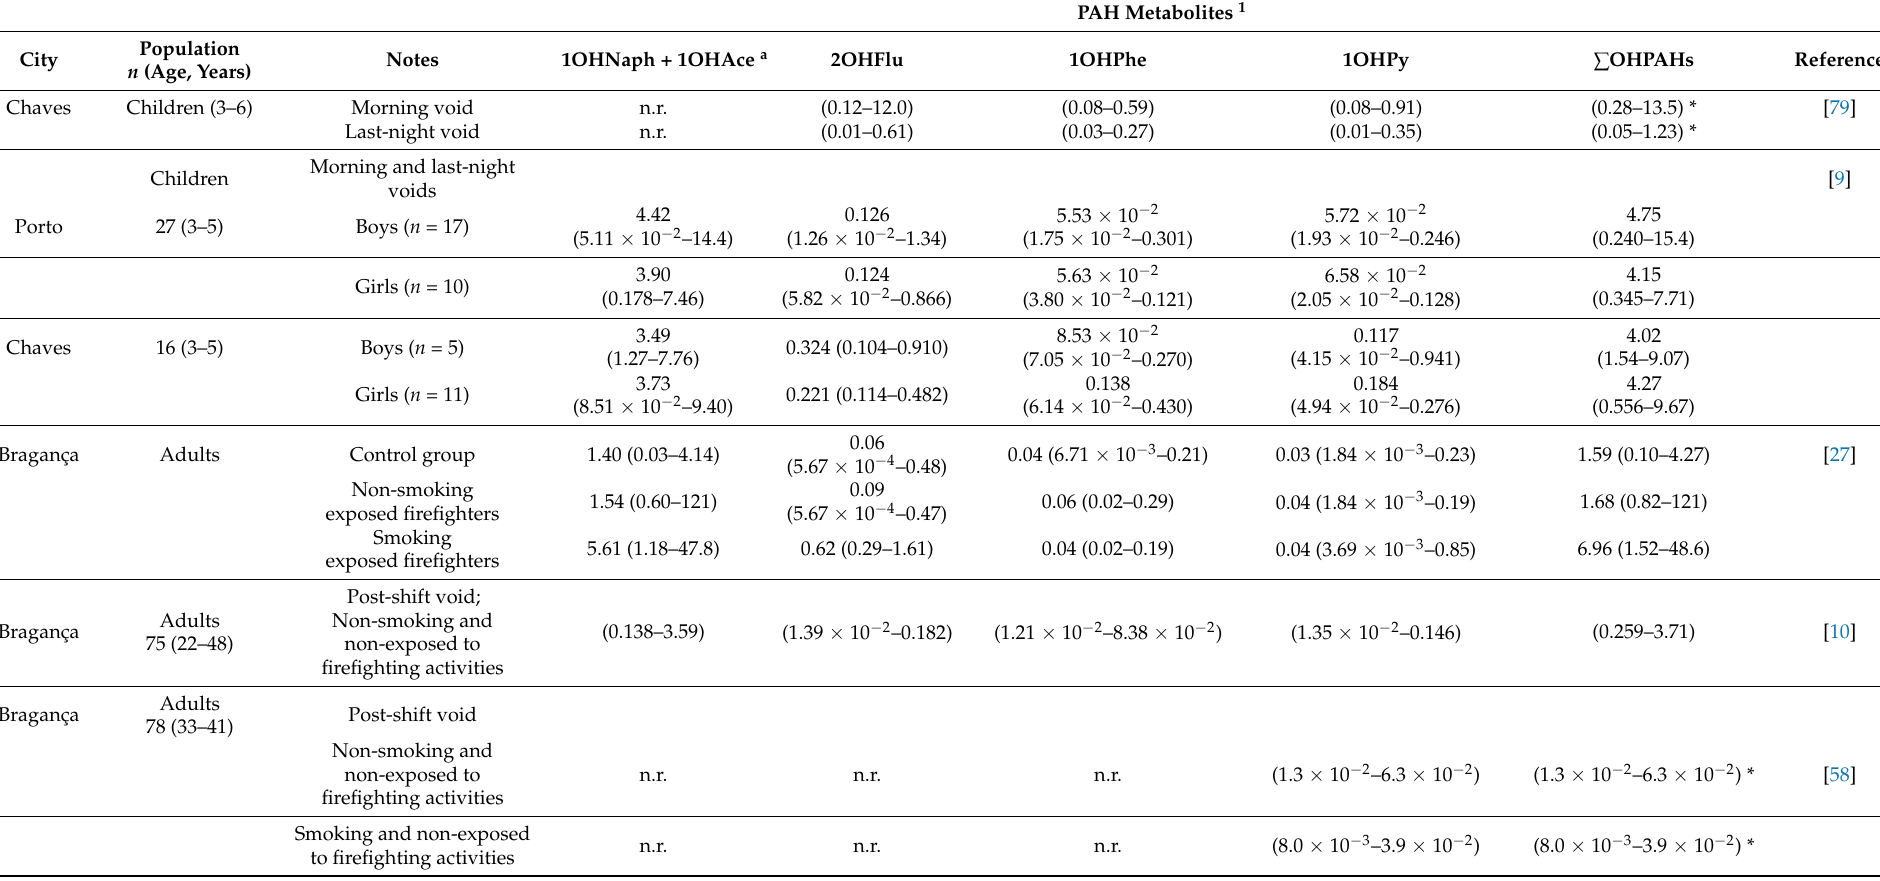
Table 1. Urinary concentrations of PAH metabolites (OHPAHs; median and/or range, expressed as µ mol/mol creatinine) reported in the Portuguese population. PAH Metabolites